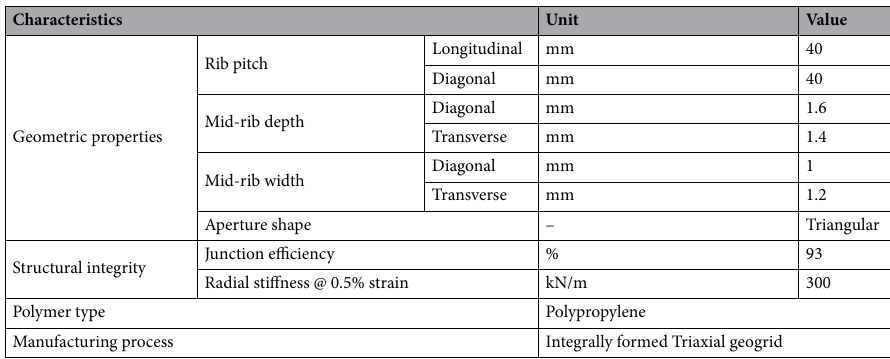
Table 4. Properties of triaxial geogrid considered.